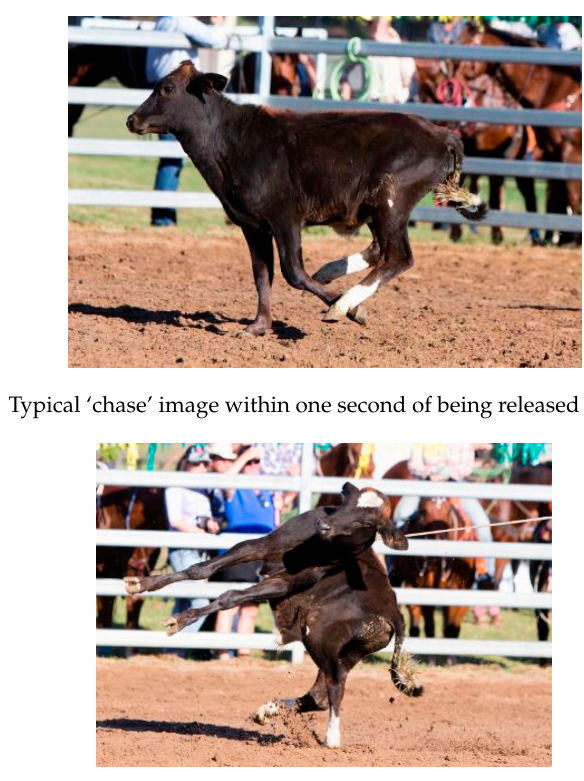
Figure 2. Typical image of calf being lassoed.